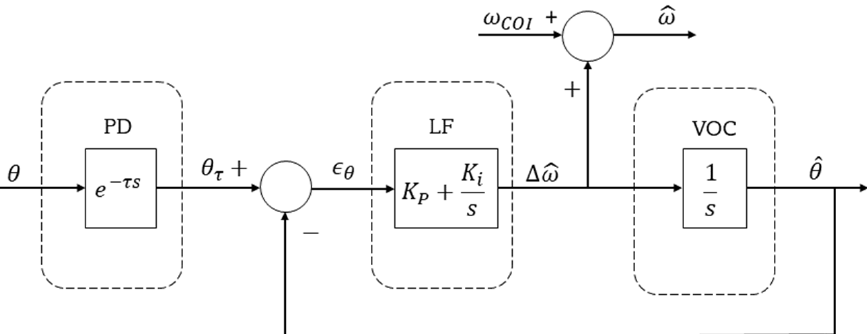
Figure 4. Diagram of the synchronous reference frame (SRF)-PLL.